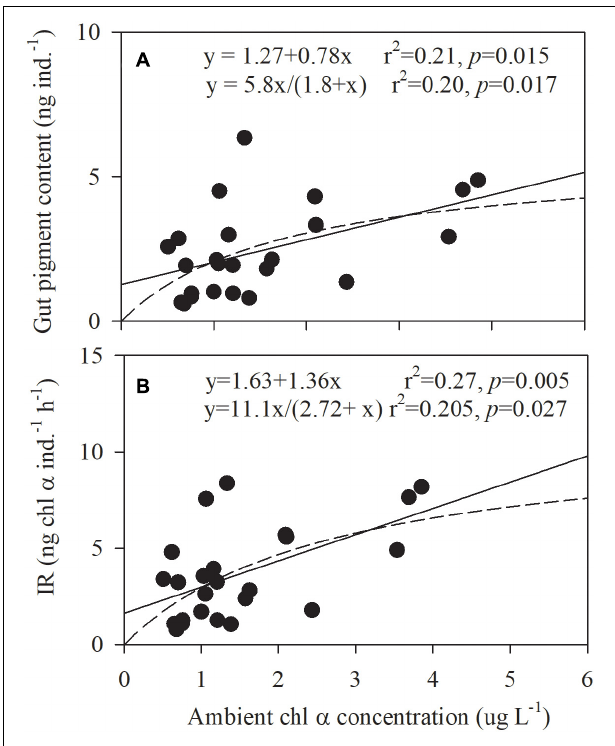
FIGURE 8 | Correlations between the (A) ingestion rate (IR) and ambient Chl α concentration and the (B) gut pigment contents and the ambient Chl α concentration in Daya Bay during September 30 to October 2, 2014.